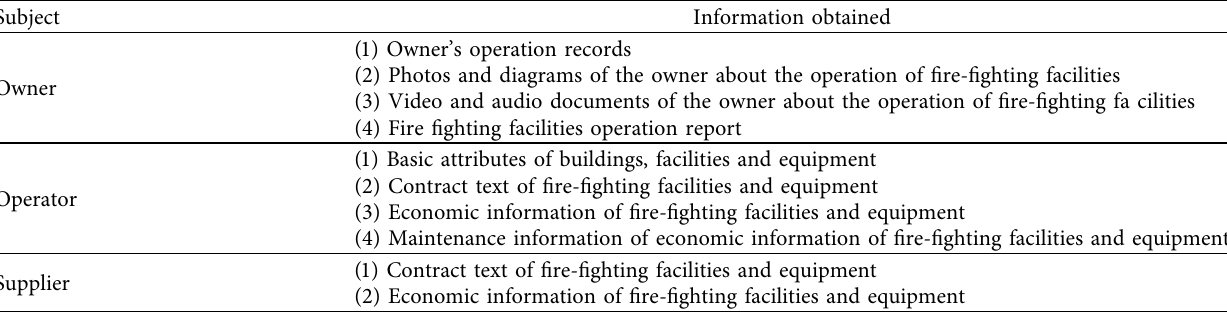
Table 5: Survey target population.